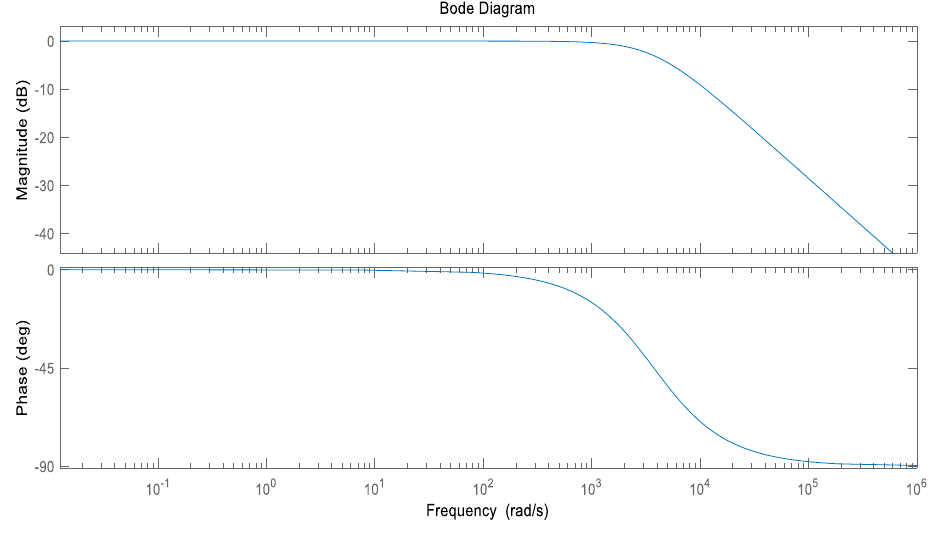
Figure 2. System bode diagram of G(s).